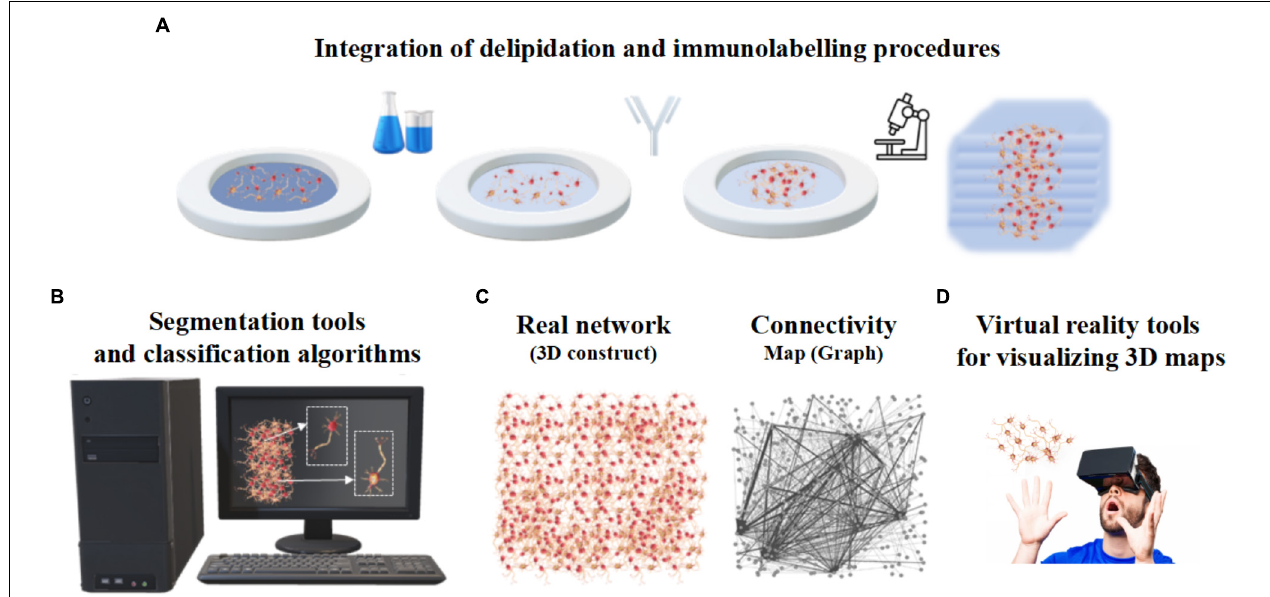
FIGURE 5 | Integrated work-flow describing the three-dimensional arrangement of cells within organoids. (A) Integration of delipidation and immunolabeling procedures. (B) Segmentation tools and classification algorithms of 3D neurons based on morphometrics such as shape and size. (C) Structural connectivity map or graph (right) describing the three-dimensional neuronal arrangement (left). (D) Virtual Reality tools for visualizing 3D